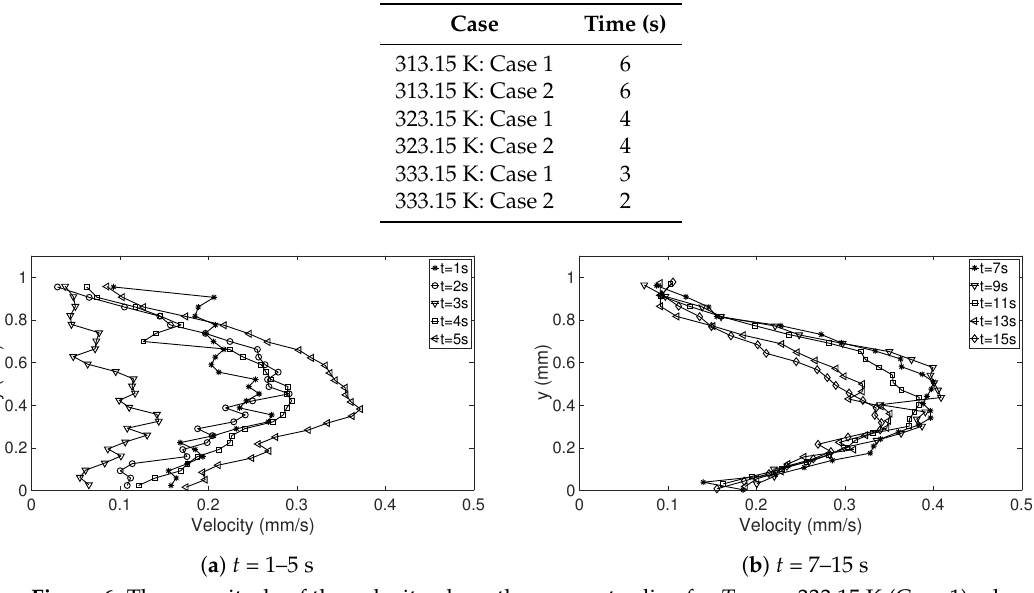
Table 6. The point in time when the flow shifts during evaporation.